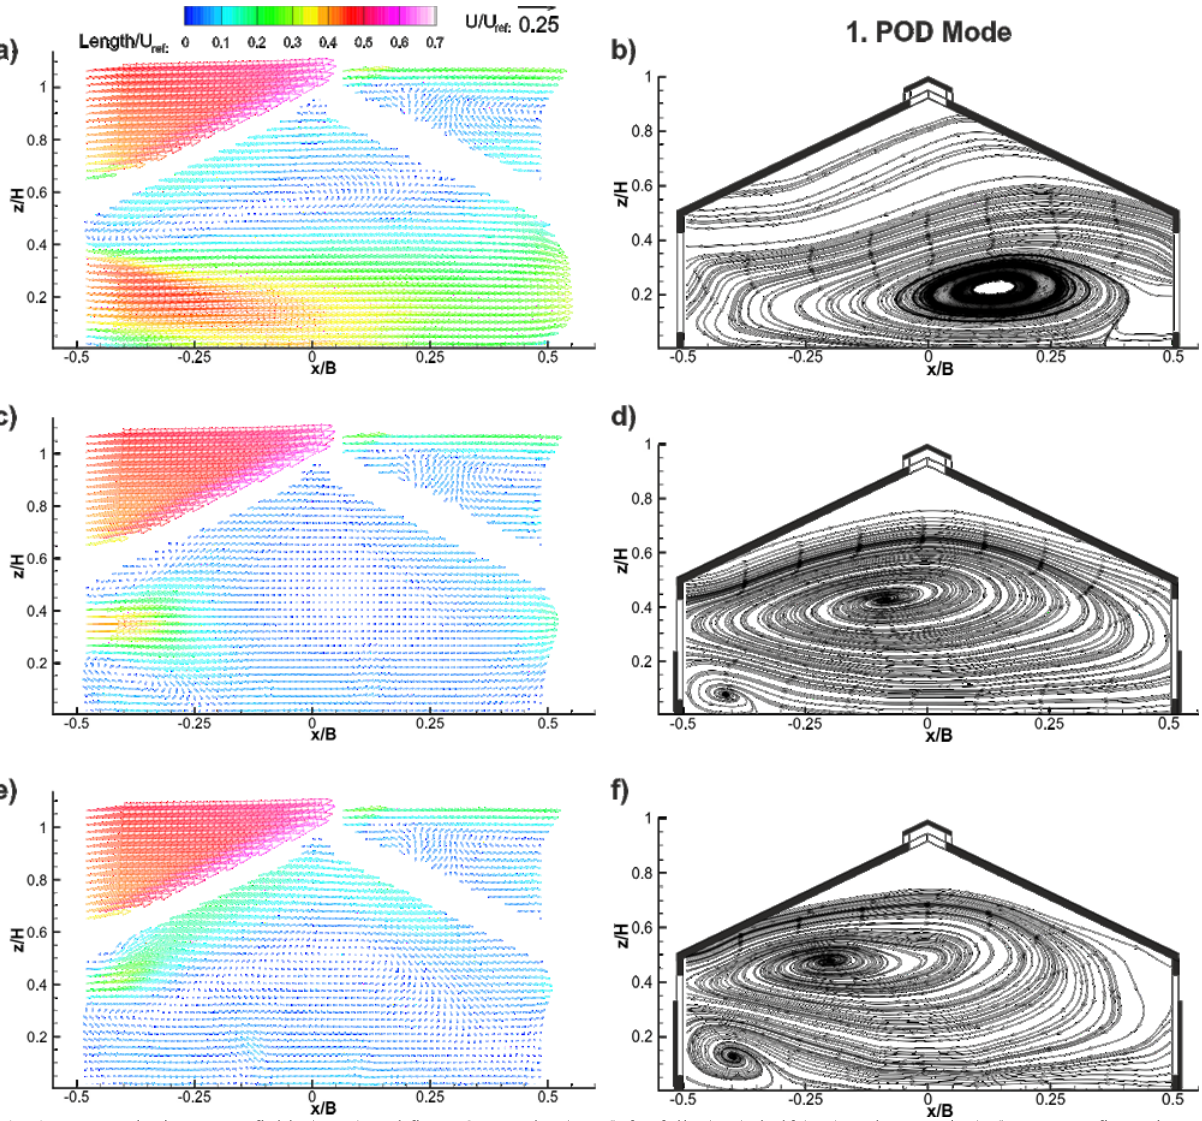
Fig. 3. Mean velocity vector fields ( a,c,e ) and first POD modes ( b,d,f ) for fully ( a,b ), half ( c,d ) and quarterly ( e,f ) open configurations. The colour of the vector corresponds to the dimensionless resultant 2D velocity ( Length/U ref ). The dimensionless reference velocity vector ( U/U ref ) is depicted in the top right of